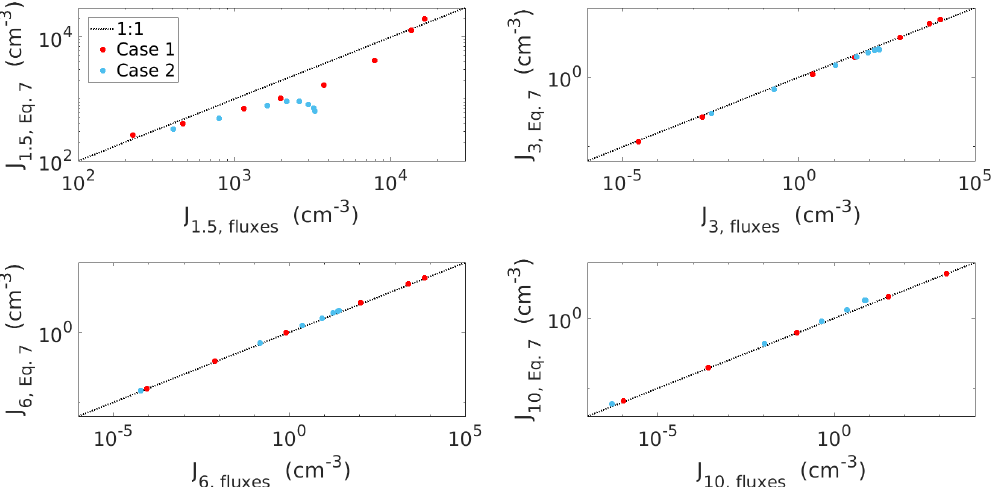
Figure 2. The formation rates ( J ) from ACDC simulations based on fluxes and Eq. (8) (marked in red) for a case with no cluster–cluster collisions (Case 1) and a case including cluster–cluster collisions (Case 2). The 1 : 1 line is included and shown with the dotted black line. J values are determined at the steady state and thus in Eq. (8) the change of the cluster number concentration with time is 0.